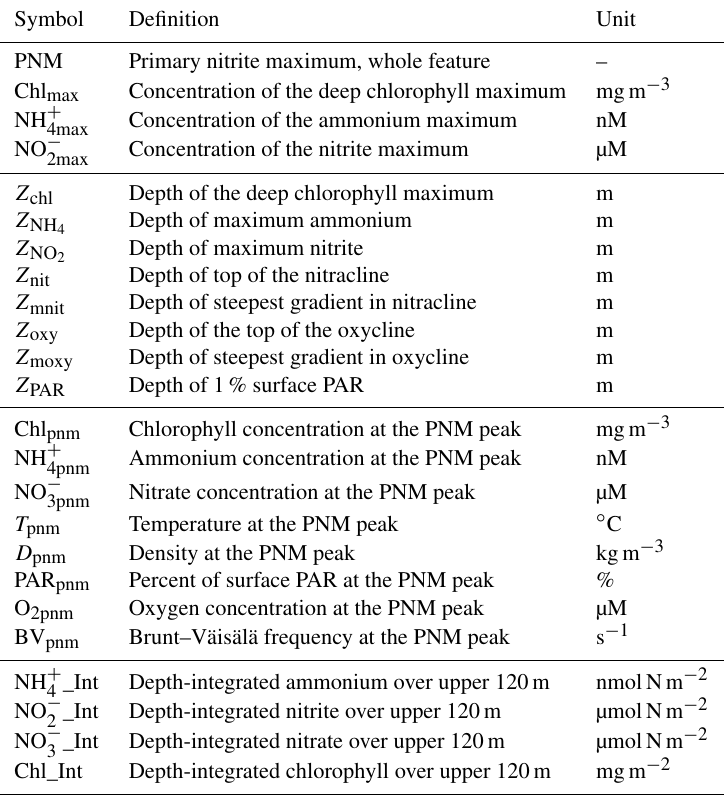
Table 1. Water column feature abbreviations, definitions and